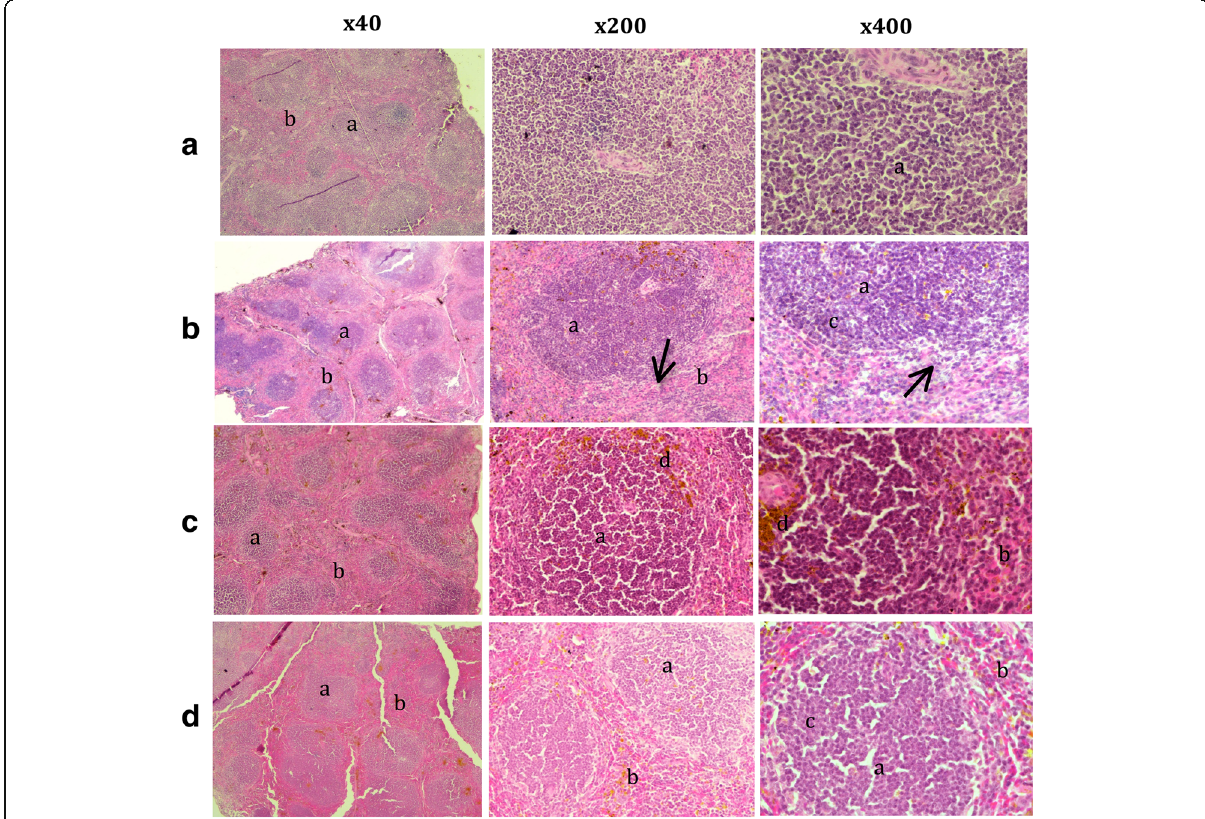
Fig. 2 Splenic section obtained after administration in mice from the following groups: a normal, b non-treatment, c combination of antibiotic and root extract, d C. mongolica root extract only. a - white pulp, b - red pulp, c - lymphocytes in different stages of development, d - haemosiderin pigmentation, ↗ - lymphocyte necrosis. Haematoxylin and eosin stain, magnification 400× and